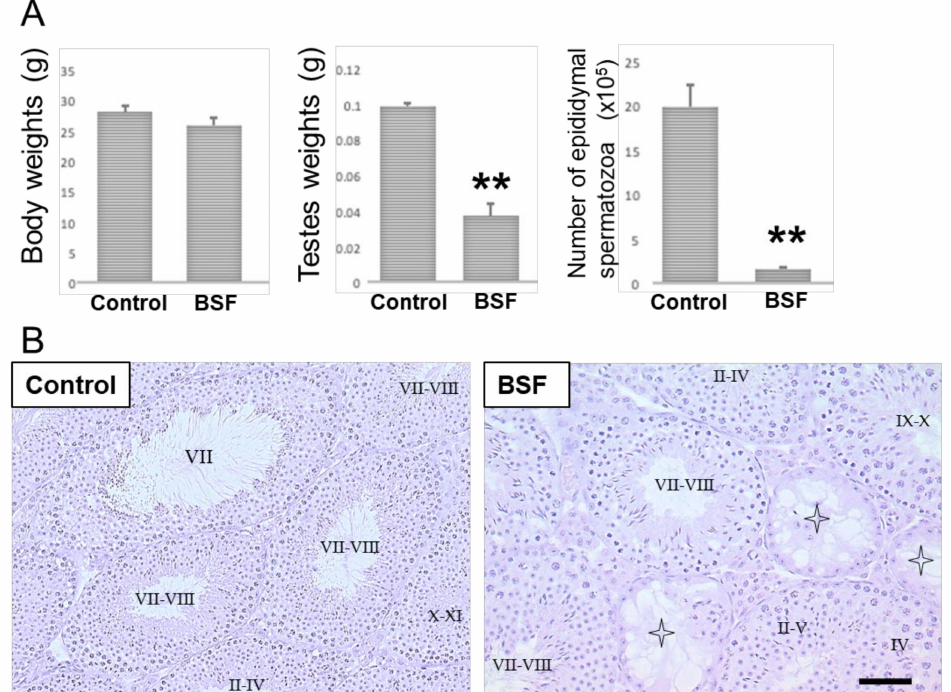
Figure 1. Body weights and reproductive changes in the DMSO-treated (control, n = 5) and the busulfan-treated (BSF, n = 5) mice on day 60 after a single intraperitoneal administration. ( A ) Body weights, testis weights, and the epididymal spermatozoa counts have been presented as mean ± standard deviation. ** p < 0.01 vs. the control group. ( B ) Light microscopic analyses. Sections stained with hematoxylin and eosin showing seminiferous tubules in testes (representative images from n = 5 mice per group). Intact seminiferous tubules showing normal stages (I-XII) of spermatogenesis from spermatogonia to spermatozoa in the cycle of germinal epithelium were observed in the control group testes. Atrophic seminiferous tubules (star pattern) with azoospermia were observed in the BSF group. Scale bar = 50 µ